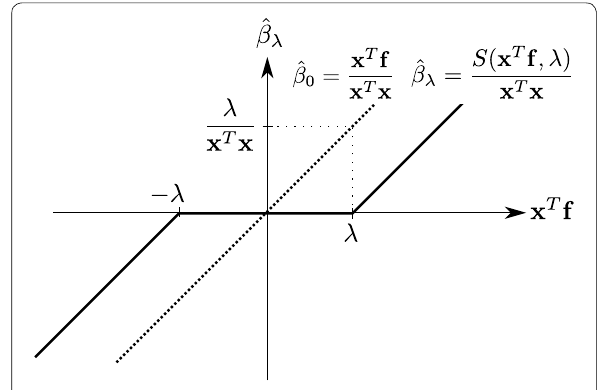
Fig. 1 A plot of the soft-thresholding operator. The solid line indicates ˆ β (cid:31)